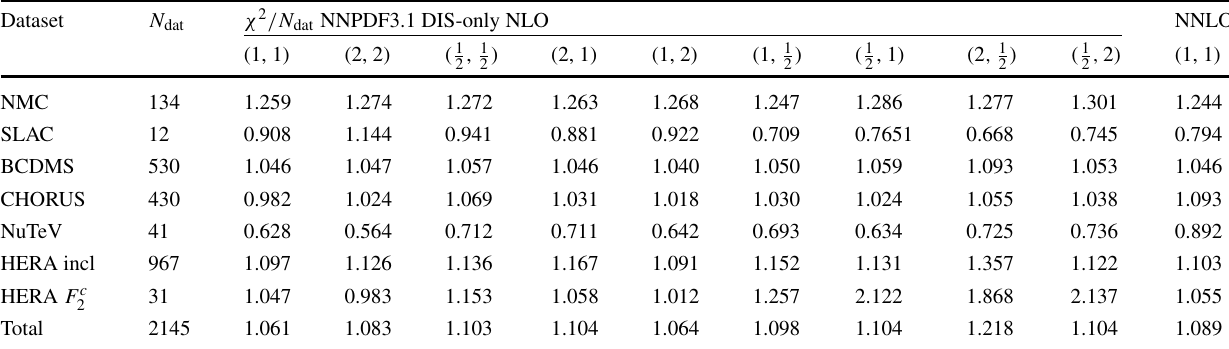
Table 14 The values of χ 2 / N dat for the DIS-only PDF sets based on scale-varied theories. We display the values of the χ 2 / N dat for the nine combination of scale variations, ( k f , k r ) , listed in Table 13. For each dataset, we also indicate the number of data points after cuts, see also Table 2